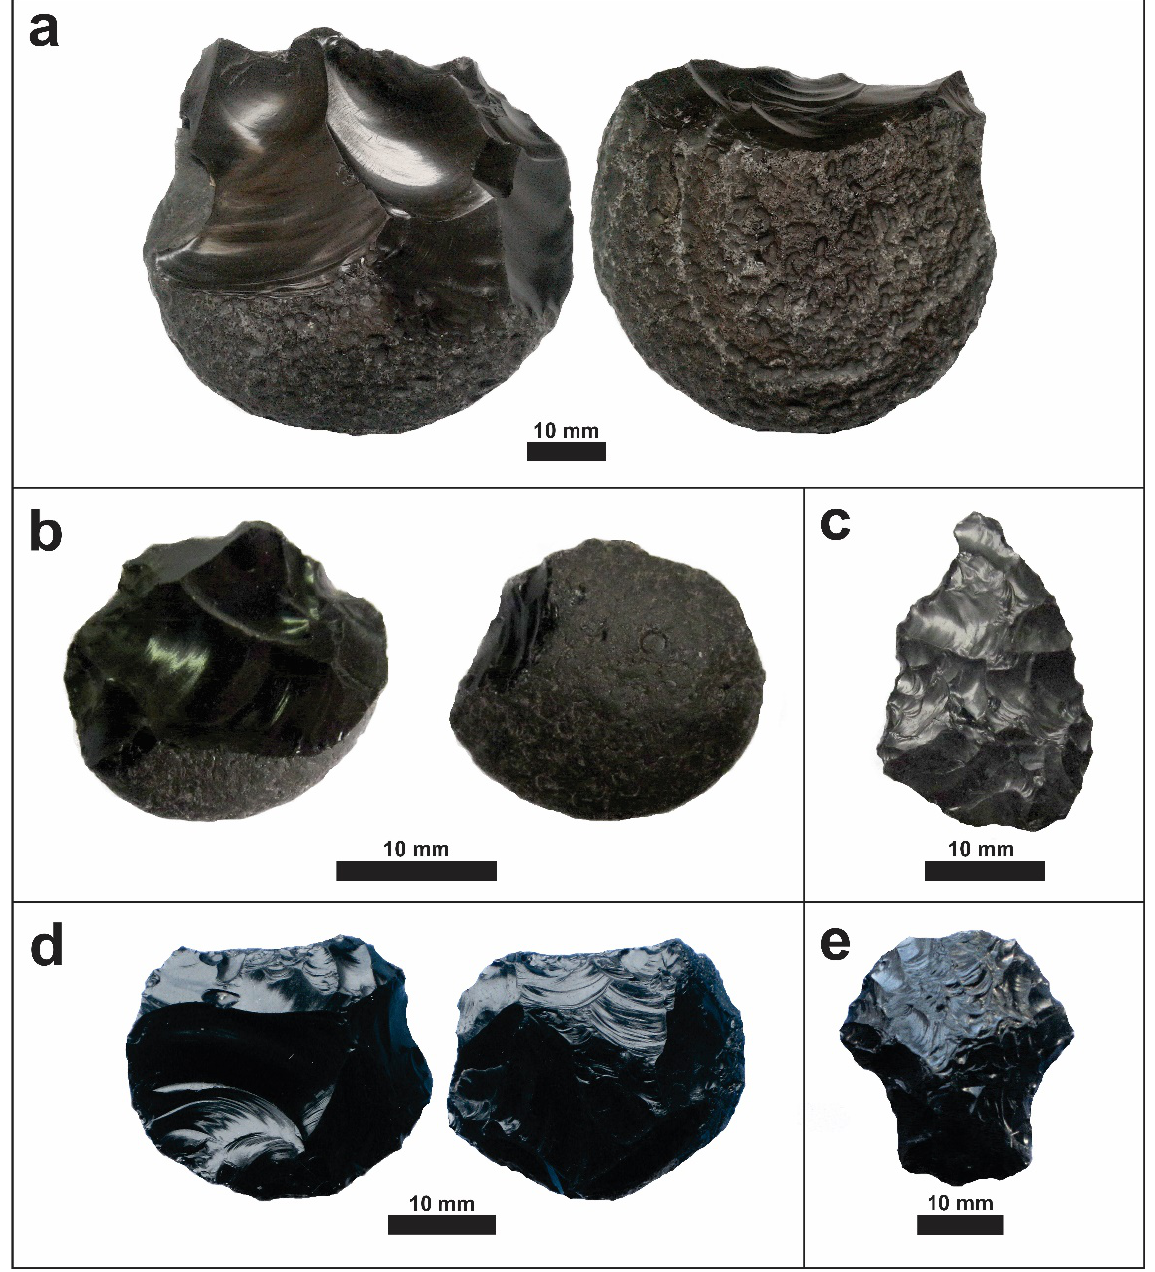
Figure 2. a: Medium-sized obsidian pebble with knapping evidence; b: Small-sized obsidian pebble with evidence of bipolar flaking; c: Obsidian bifacial preform; d: Bipolar core on small obsidian pebble; e: Projectile